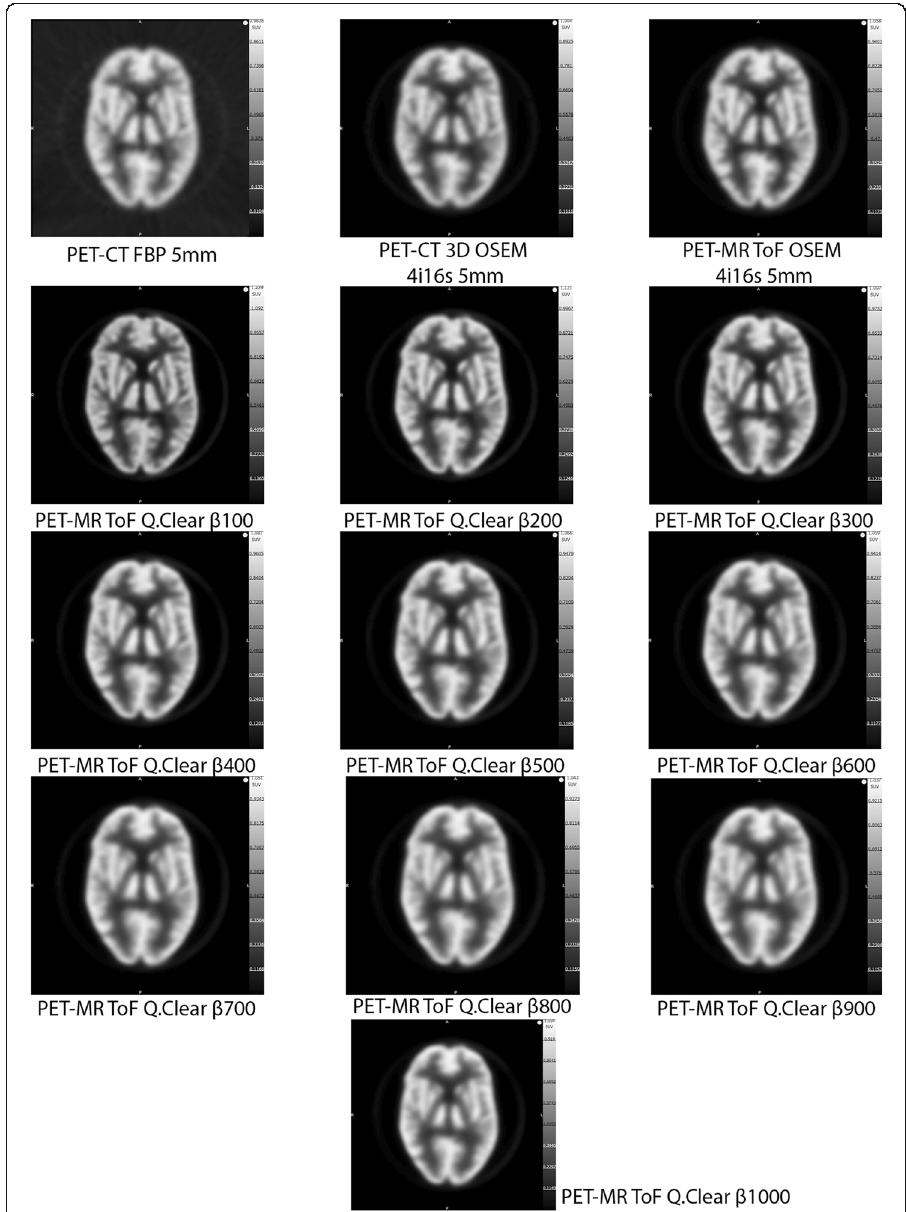
Fig. 8 Hoffman phantom filled with 11 C-SA4503 and 11 C-UCB-J in the PET-CT and PET-MR. FBP and 3D OSEM 4 iterations, 16 subsets, 5 mm filter obtained in the PET-CT are displayed. TOF OSEM 4iterations 16 subsets, 5 mm filter, and TOF Q.Clear β 100 to 1000 obtained in the PET-MR are also displayed. Note the visual differences in image quality for the Q.Clear reconstructions as β